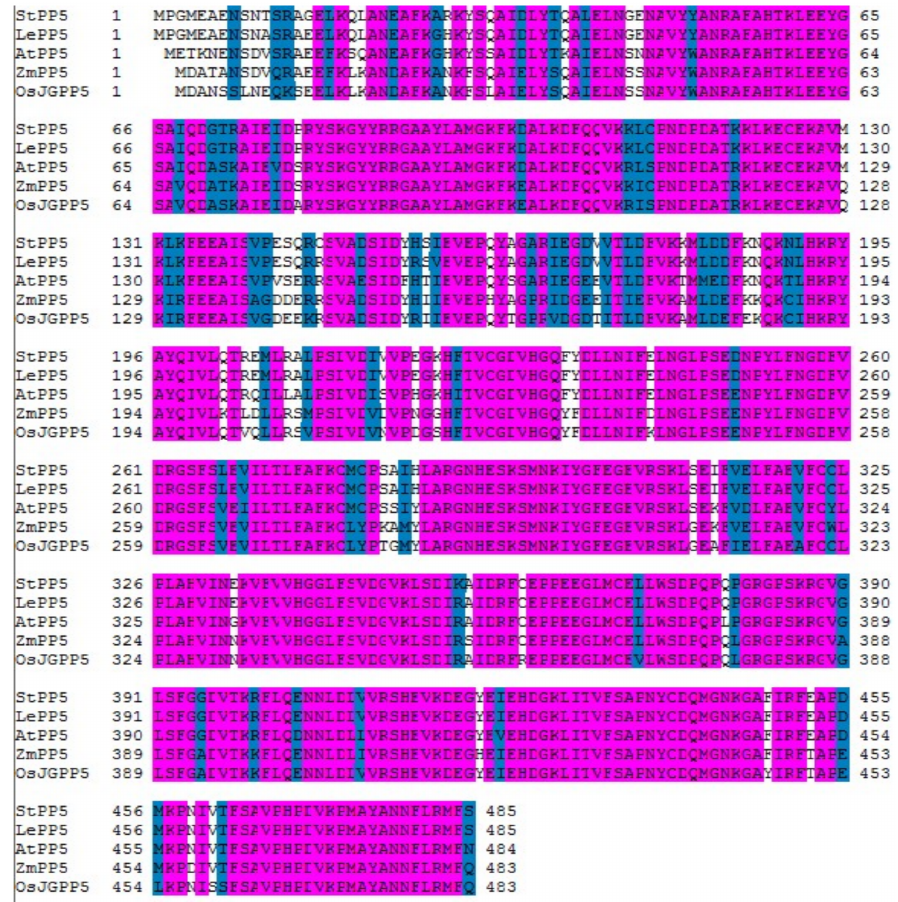
Figure 2. Alignment of the amino acid sequence of StPP5 with that of other homologous: LePP5 (AAN64317), AtPP5 (NP-565985), ZmPP5 (NP-001150042), and OsJGPP5